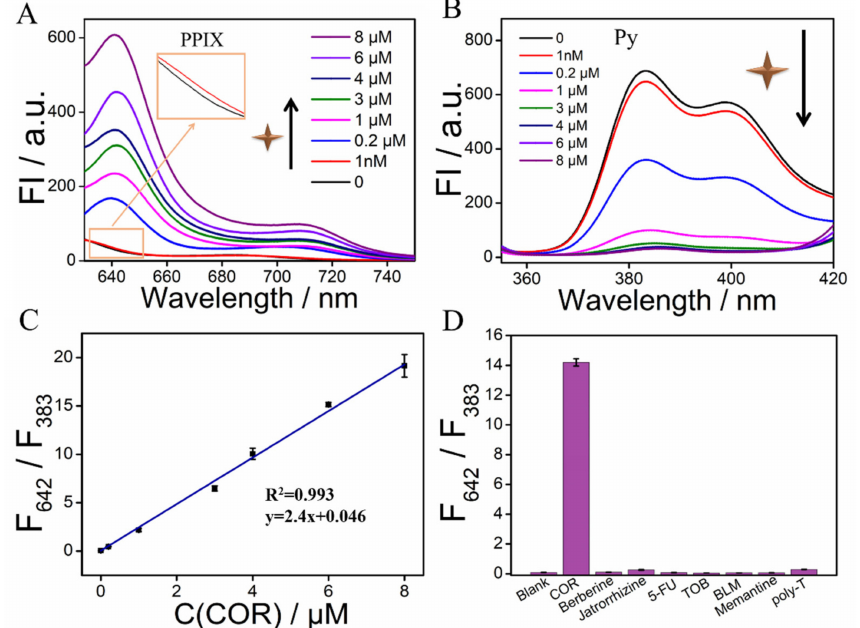
Figure 3. ( A ) Fluorescence spectra of PPIX in the presence of different concentrations of COR; ( B ) Flu- orescence spectra of Py in the presence of different concentrations of COR; ( C ) Linear relationship between the fluorescence ratio F 642 /F 383 and the concentration of COR; ( D ) Comparison of the fluorescence ratio F 642 /F 383 with other alkaloids, drugs and poly-T strands for this system. The error bars are obtained via three independent